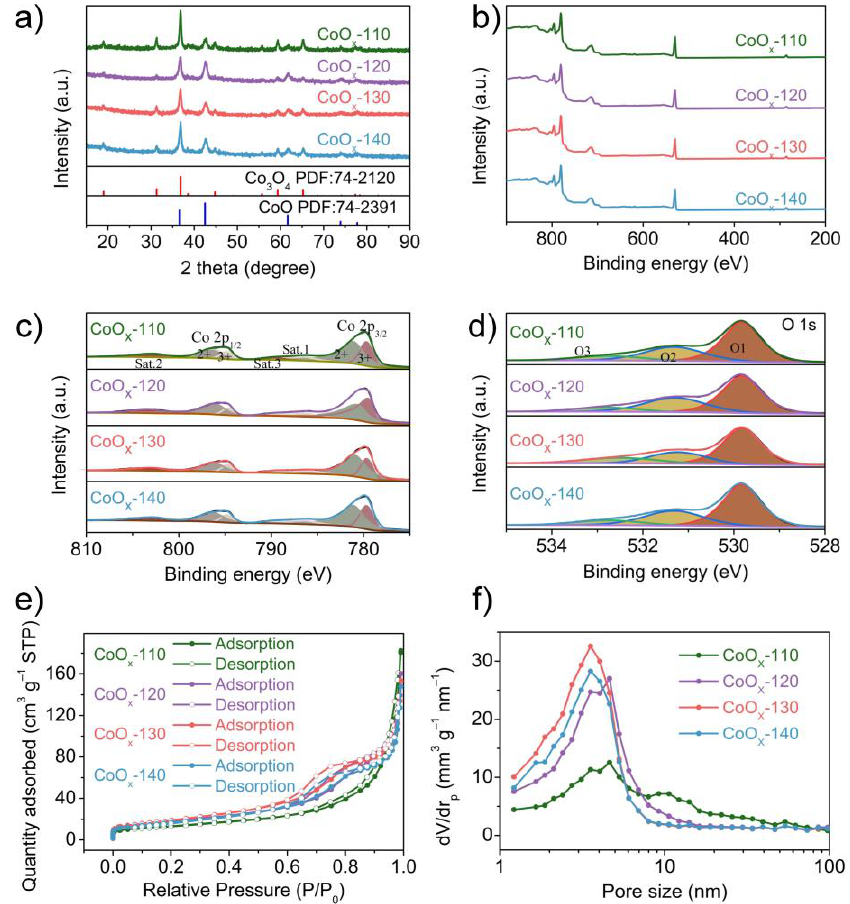
Figure 2. ( a ) XRD pattern, ( b ) XPS survey spectrum, high-resolution XPS spectra for the ( c ) Co 2p, and ( d ) O 1s, ( e ) N 2 adsorption and desorption isotherms, and ( f ) pore size distributions of the CoO x - 110, CoO x -120, CoO x -130, and CoO x -140